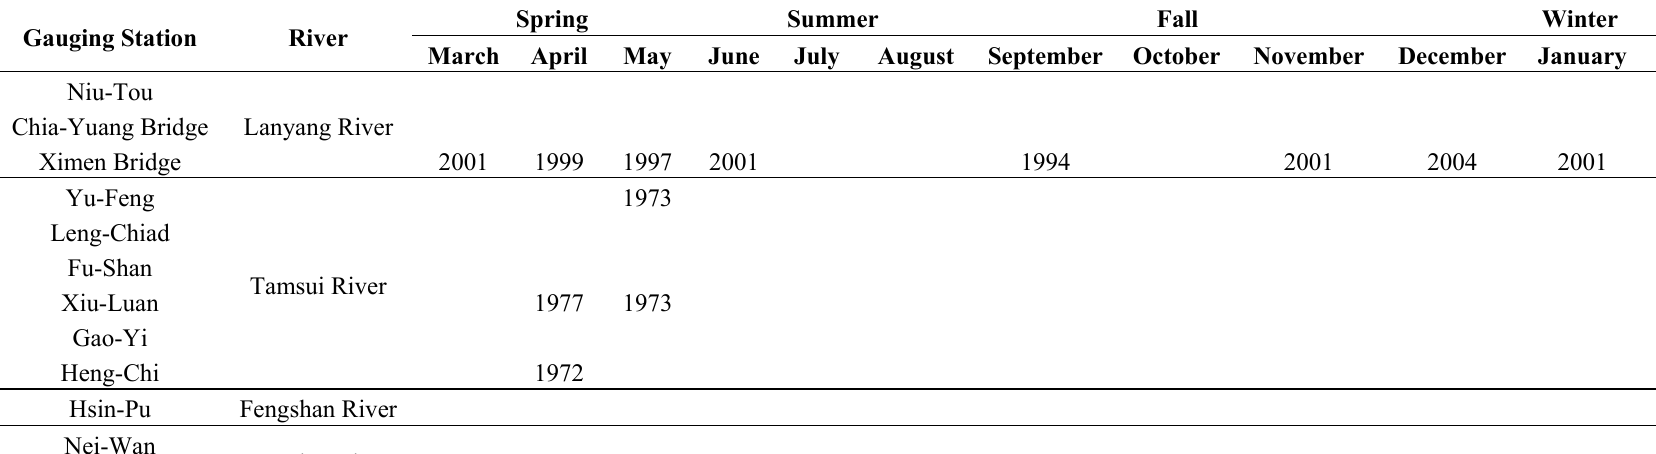
Table 6. Results for the change points of the monthly mean streamflow.